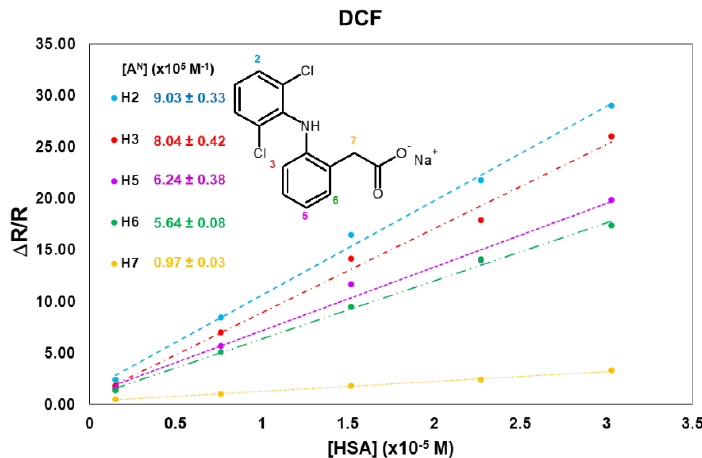
Figure 2. Normalized mono-selective relaxation rates plotted vs. HSA concentration, and calculated affinity indexes for DCF protons.